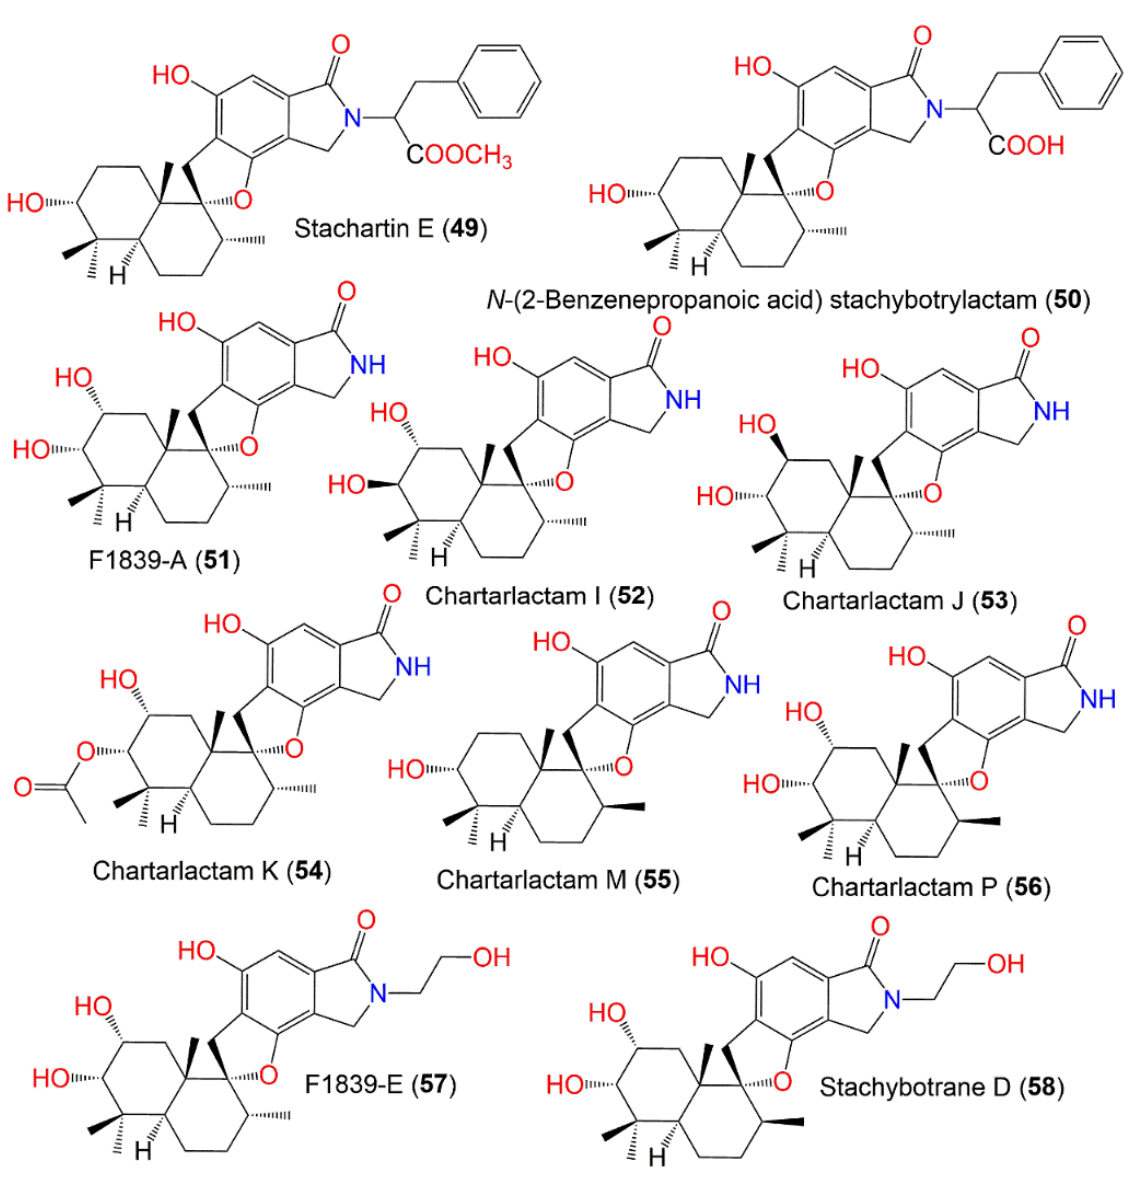
Figure 5. Structures of phenylspirodrimane derivatives ( 49 – 58 ) reported from S . chartarum . The antihyperlipidemic effects of 29 , 30 , 40 – 44 , 50 – 57 , 65 , 67, 69 , 71 , and 72 (Figure 6) in HepG2 cells were estimated utilizing a cell-based lipid accumulation assay. The results revealed that 43 , 44 , 50 , 54 , 65 , 68 , 69 , and 72 (Conc. 10 µ M) possessed significant lipid- lowering potential in HepG2 cells. Besides, 44 , 50 , 54 , 65 , and 69 displayed remarkable prohibition of intracellular TG (triglyceride) levels, whereas 43 , 44 , 50 , 65 , 68 , and 72